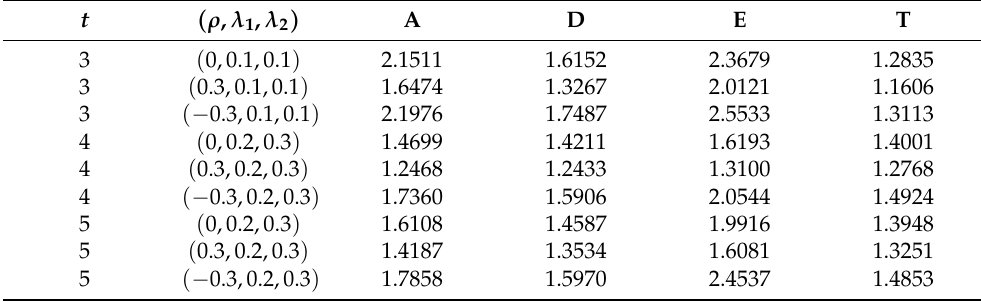
Table 2. Comparison of the Φ p for optimal designs under circular and noncircular setups estimating total effects with different combinations of ( ρ , λ 1 , λ 2 ) when k =